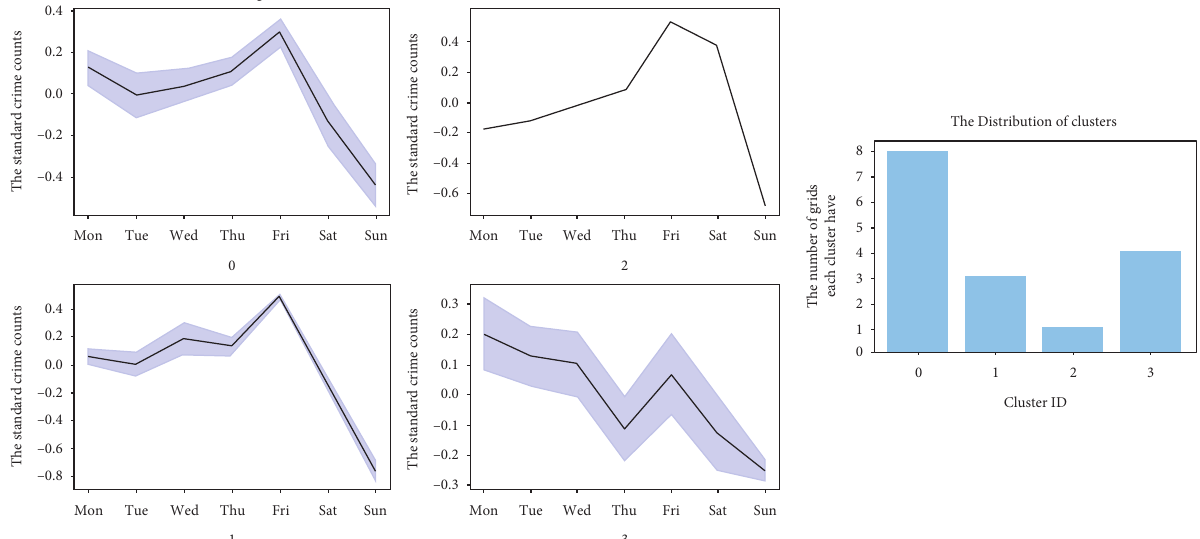
Mon Tue Wed Thu Fri Sat